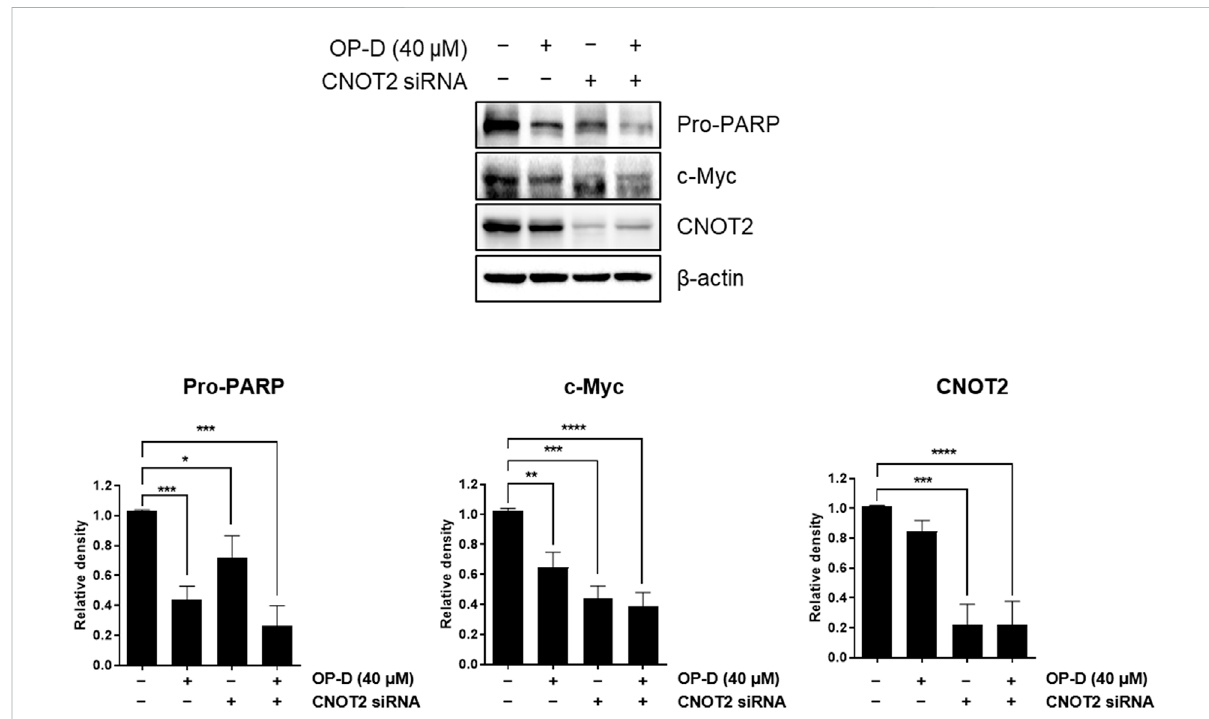
FIGURE 8 OP-Dinhibitsc-Myc via CNOT2inHCT116 p53+/+ cells.HCT116 p53+/+ cellsweretransfectedwithCNOT2siRNAorcontrolsiRNA(80nM)for50h. And then, cells were treated with OP-D (0 or 40 μ M) for 24 h. Cell lysates were performed for Pro-PARP, c-Myc, CNOT2, and β -actin by Western blotting. Data represent means ± SD. * p < 0.05, ** p < 0.01, *** p < 0.005, *****p p < 0.001 versus untreated